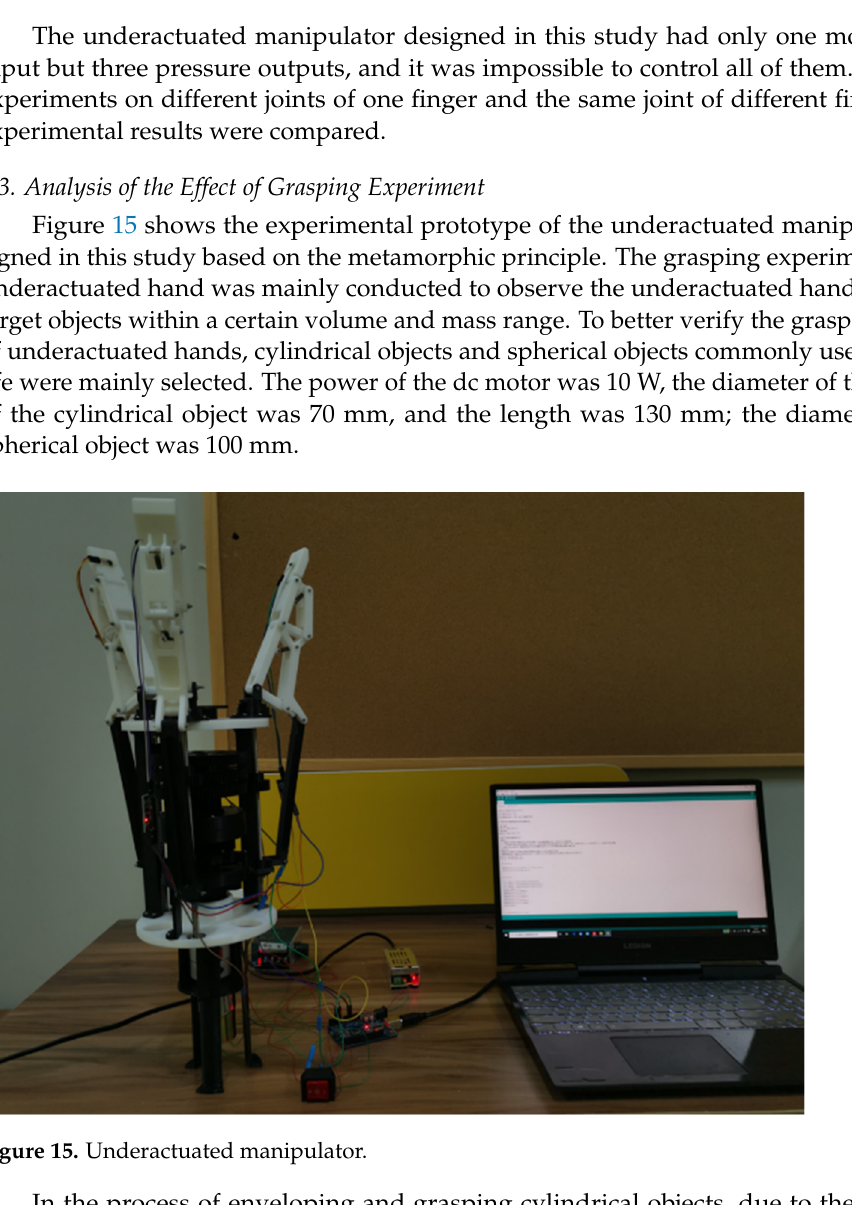
Figure 16. Finger branch adaptive structure.